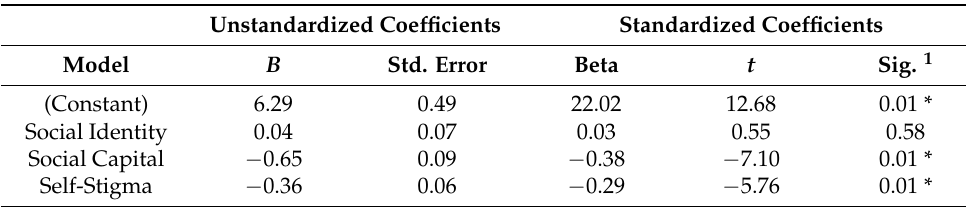
Table 1. Analysis of multiple regression results of independent variables on help-seeking for personal or emotional problems.